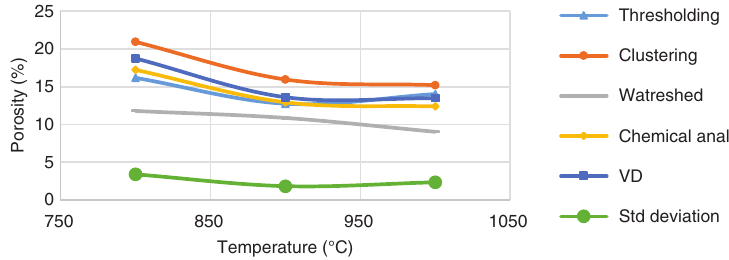
Figure 2: Porosity Estimation-Based VD versus Physical Process for the Sample S 0 .